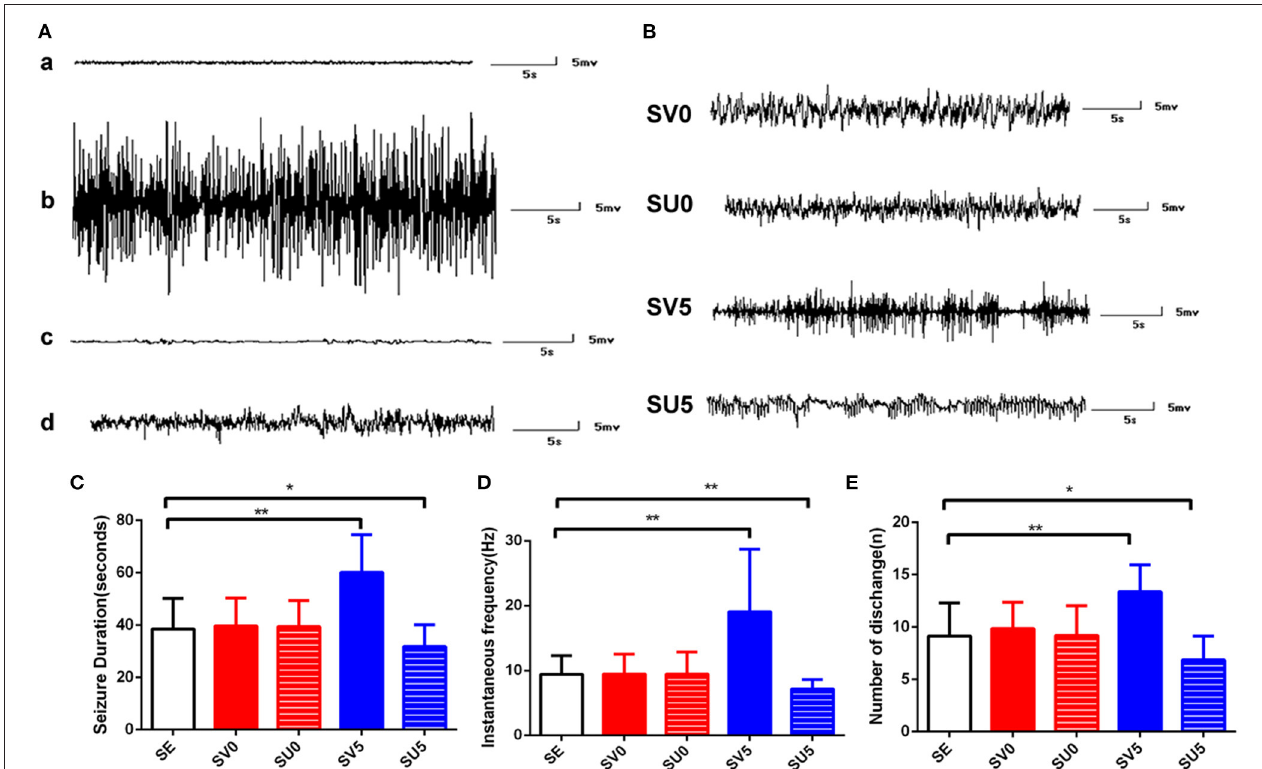
FIGURE 7 | EEG recordings of rats from different groups during different periods. (A) EEG recordings from rats in the SE group during epileptogenesis. (a) EEG recording from a normal immature rat. (b) EEG recording from a rat in the acute phase after SE. (c) EEG recording from a rat in the latent period of epileptogenesis after SE. (d) EEG recording of SRS in the SE group. (B) EEG recordings of SRS in the different intervention groups. (C) SRS duration, (D) seizure frequency and (E) the number of discharges during the SRS phase after SC. * P < 0.05, ** P <